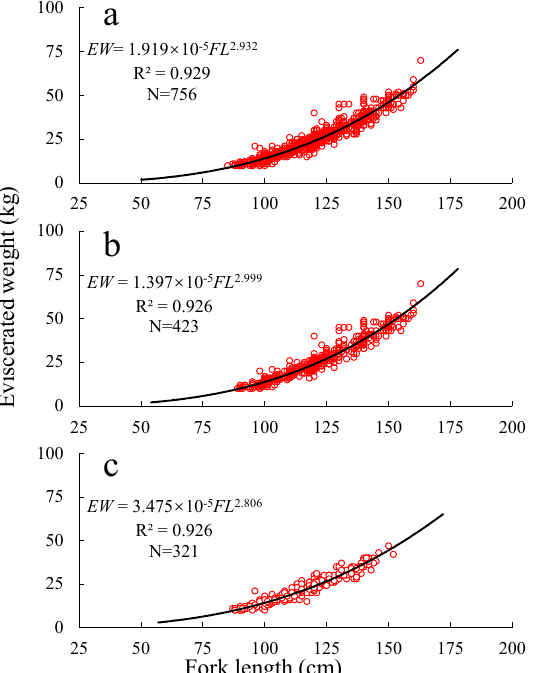
Figure 2. Fork length (FL) composition columns by sex ( a ) and month ( b ) and the proportion of males (line) in T. albacares .